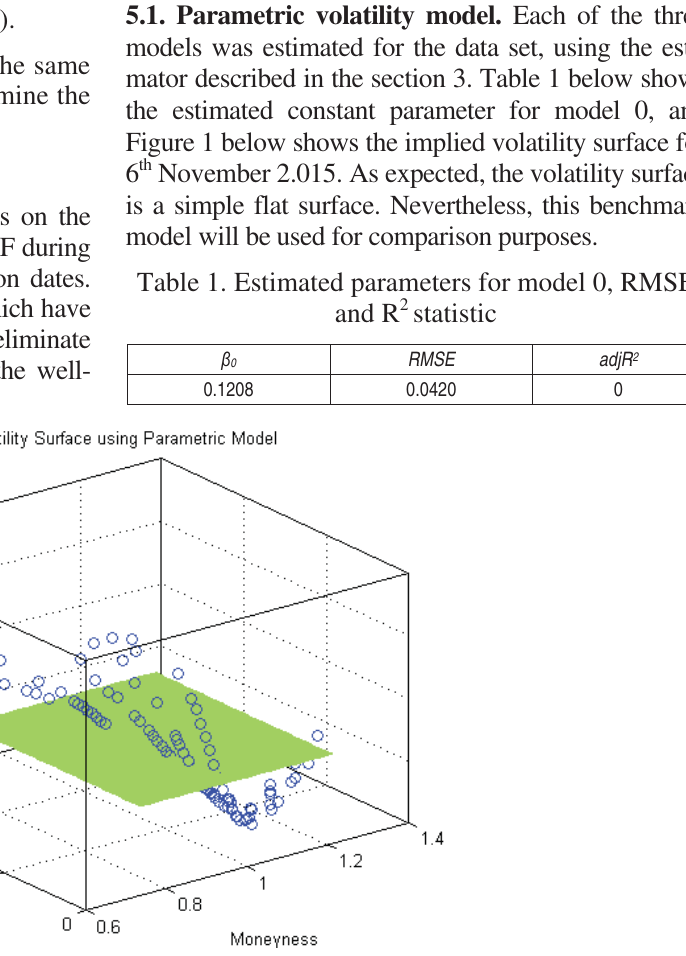
Fig. 1. Estimated implied volatility surface for model 0. The blue circles are the observed